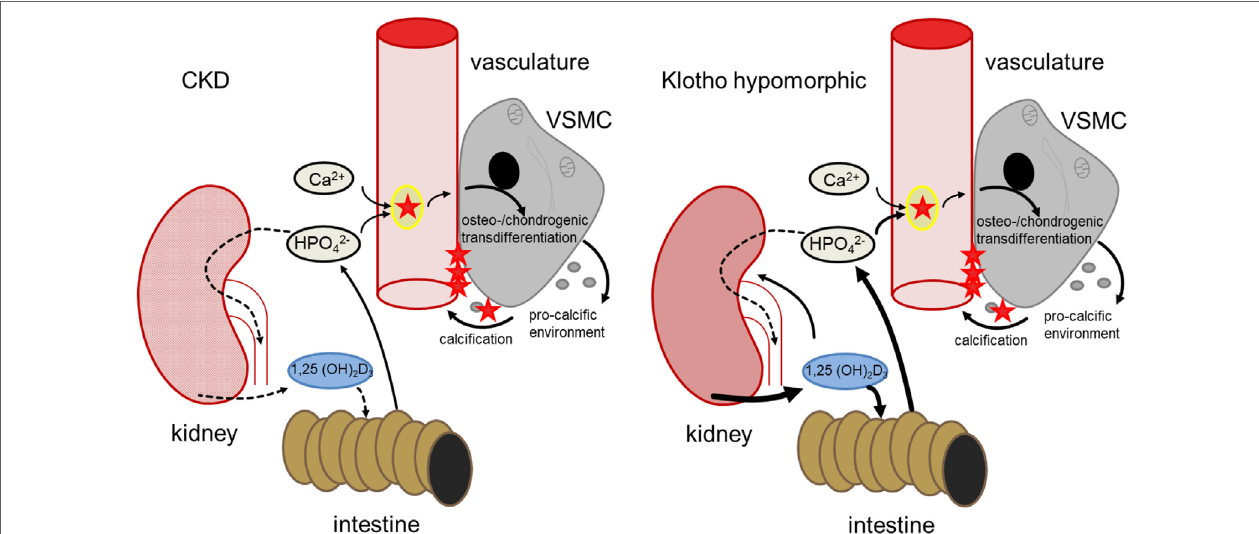
FigURe 1 | Comparison of hyperphosphatemia due to chronic kidney disease (CKD) (left) and klotho deficiency (right). In CKD, renal failure leads to impaired phosphate elimination and reduced formation of calcitriol [1,25(OH) 2 D 3 ]. Phosphate overload and formation of secondary calciprotein particles (CPPs) (48) induce an osteogenic remodeling of vascular smooth muscle cells (VSMCs), causing matrix-vesicle release and a pro-calcific environment and subsequent vascular mineralization. In klotho-hypomorphic mice, klotho deficiency causes an unrestrained calcitriol formation. This causes increased intestinal and renal phosphate reabsorption, increasing phosphate levels. Therefore, despite the potential anti-calcific effects of calcitriol (49), this phosphate overload exceeds the capabilities of anti-calcific mechanisms in the body and may induce a comparable osteo-/chondrogenic transdifferentiation of VSMCs. Although the origin of hyperphosphatemia differs between CKD and kl/kl mice, both presumably suffer from excessive phosphate concentrations and increased formation of secondary CPPs to induce a similar VSMC-mediated